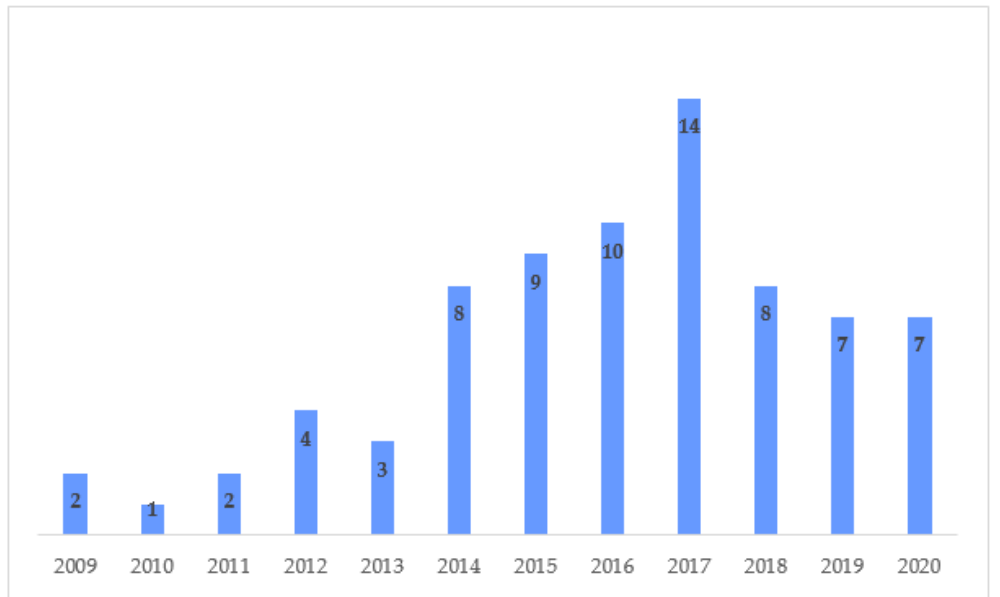
Figure 2. Distribution of the reviewed papers by year of publication.